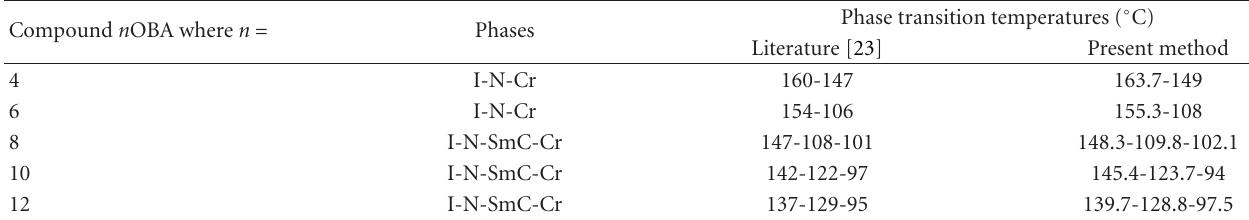
Table 1: Textures and phase transition temperatures of homeotropically aligned p , n -alkyloxybenzoic acid mesogens ( n = 4, 6, 8, 10, and